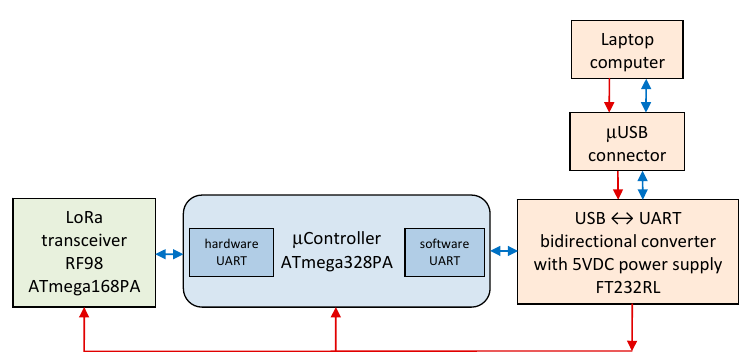
Figure 3. Application layer schematic diagram (red arrows—power lines, blue arrows—data lines).